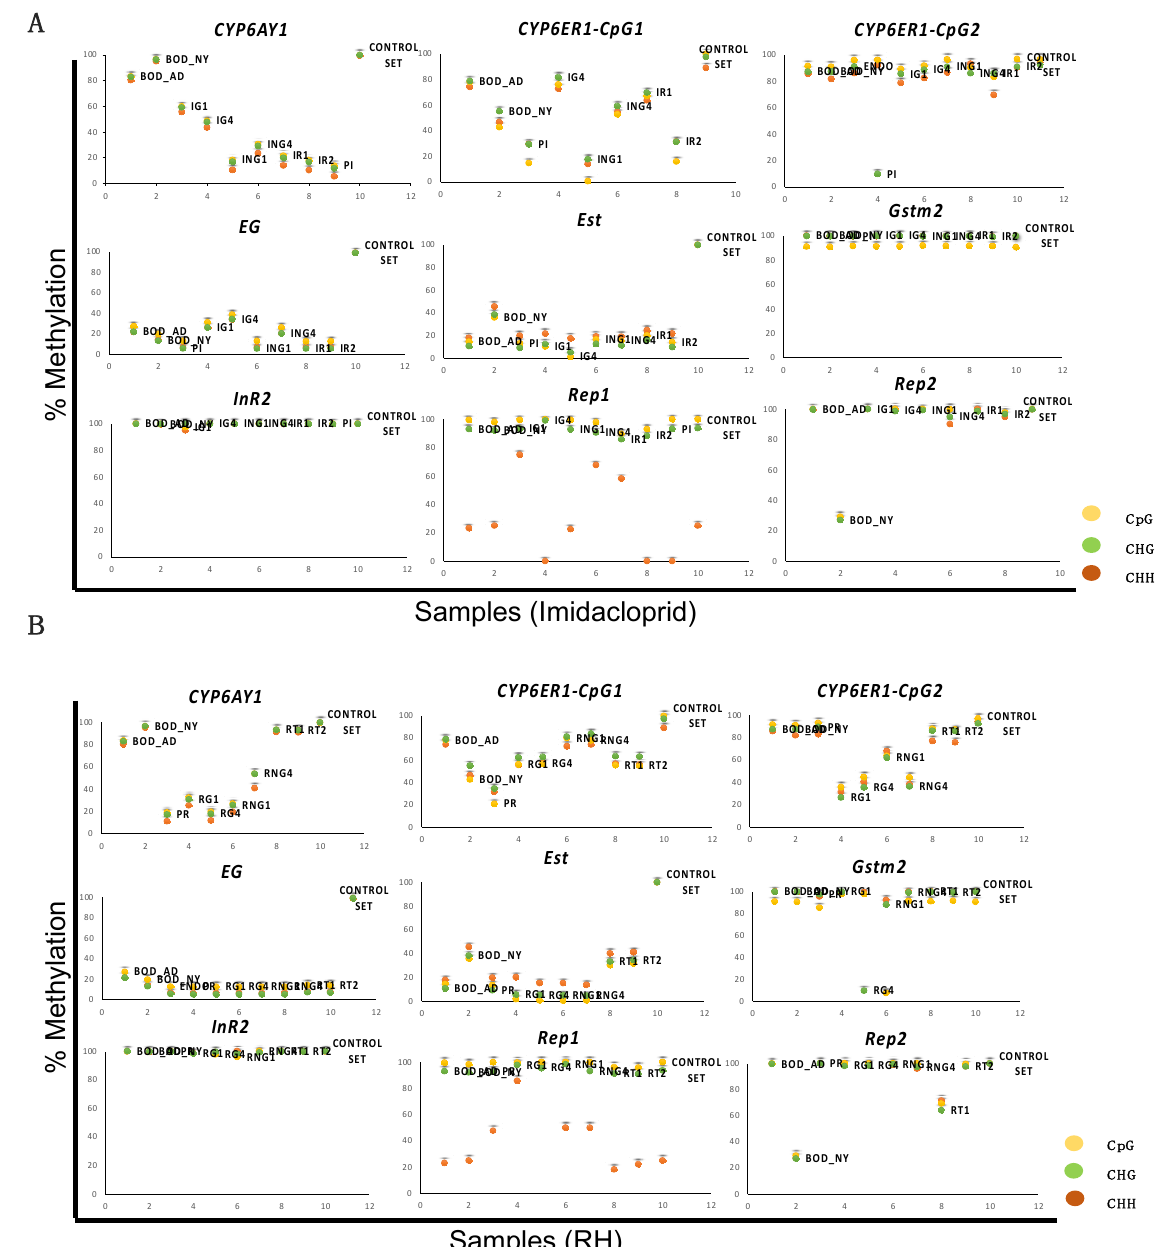
BPH populations.